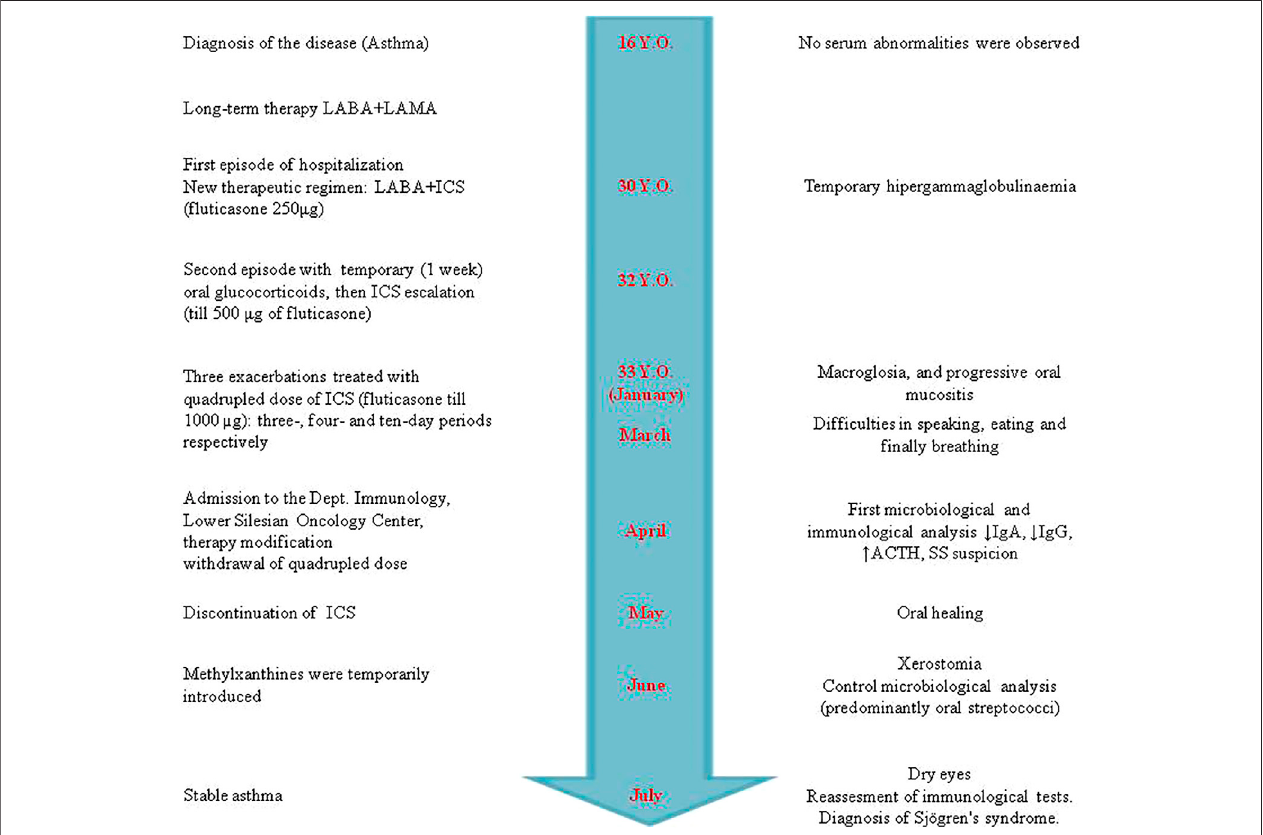
FIGURE 1 | Timeline of clinical presentation, therapeutic regimen of asthma, and Sjögren ’ s syndrome development. The course and therapeutic interventions of asthma are presented on the left. The right side shows the sequence of symptoms and immune parameters during the development of Sjögren ’ s syndrome. In contrast to the similar adverse drug reactions (ADRs), i.e., drug-induced lupus (DIL), disappearance of clinical manifestation was not observed. The patient has Sjögren ’ s syndrome (SS) symptoms even now [more than a year and a half after the inhaled corticoid (ICS) discontinuation].